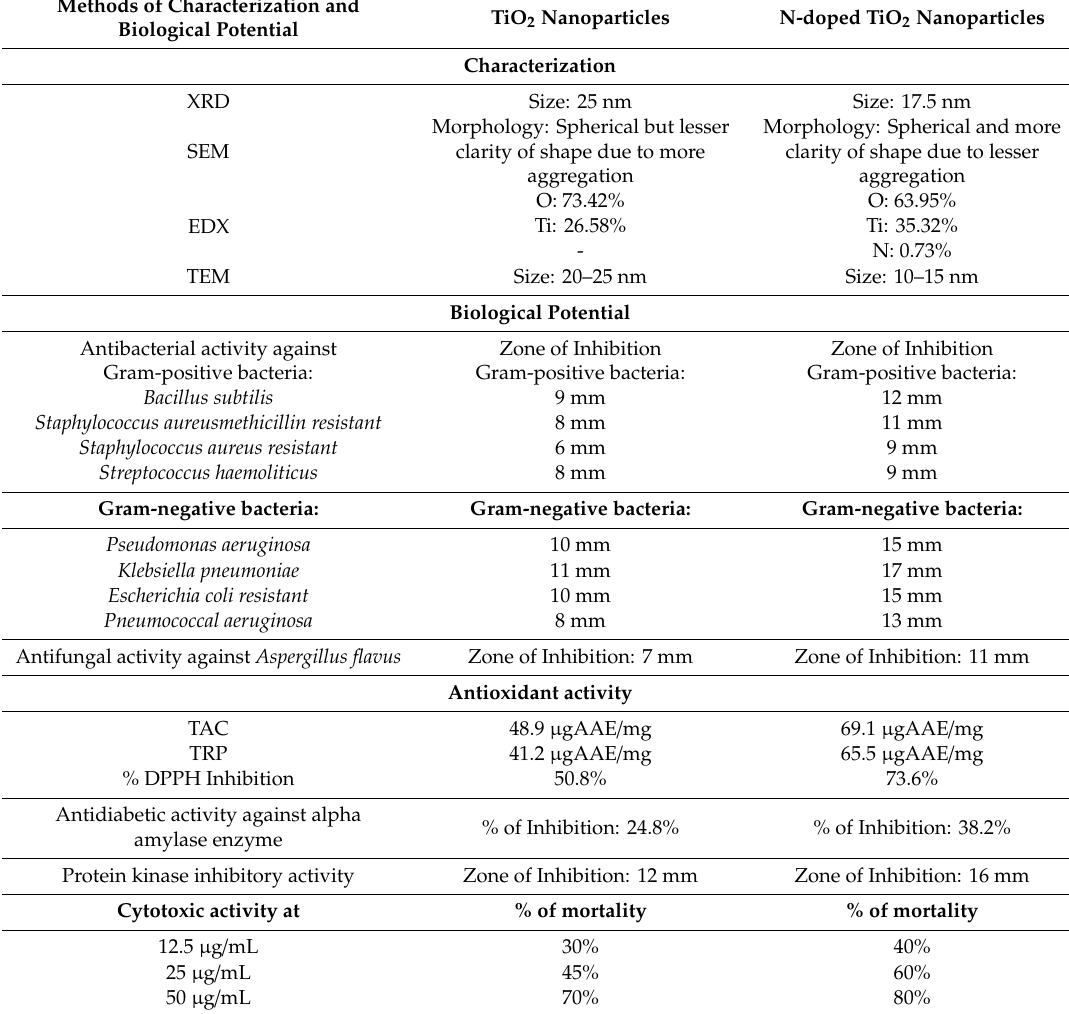
Table 1. Summary of results of TiO 2 nanoparticles and N-doped TiO 2 nanoparticles with respect to their characterization techniques and therapeutic